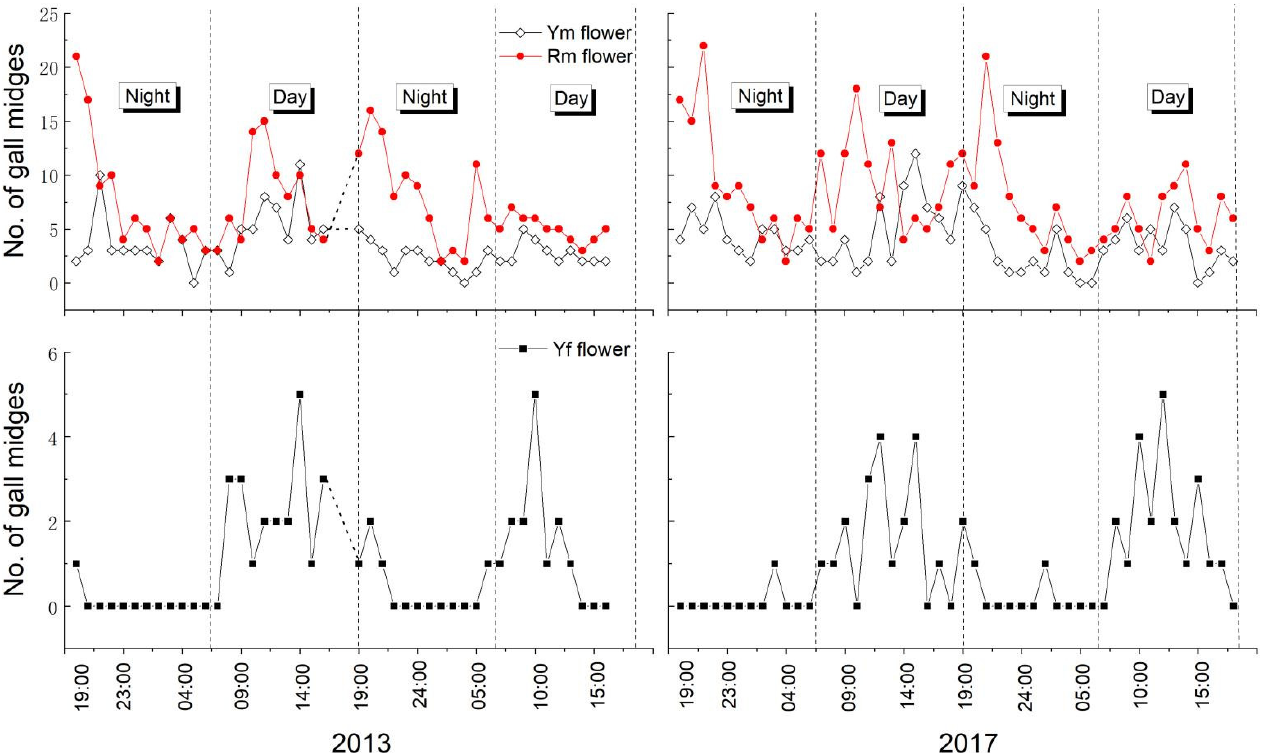
Figure 1. Visiting dynamics of gall midges on the three flower phenotypes of Schisandra sphenanthera under natural